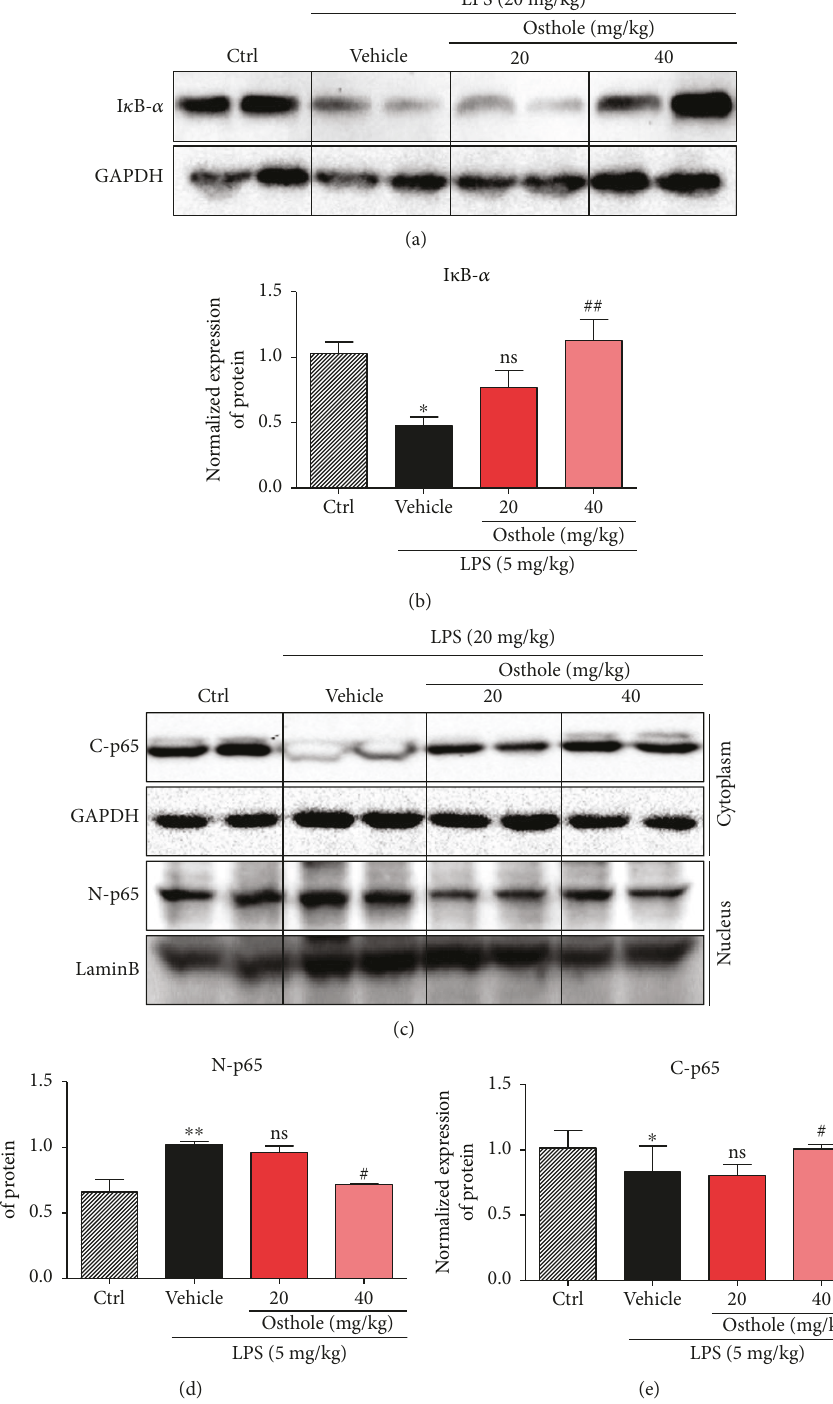
Figure 6: Osthole suppresses NF- κ B signaling in vivo . ALI was induced as described (Materials and Methods). Brie fl y, C57BL/6 mice were pretreated for 30 min with 20mg/kg or 40mg/kg osthole via ip injection, followed by intratracheal injection of 5mg/kg LPS, and lungs were sampled 6h later for Western blot analyses. (a) Representative Western blot detecting for I κ B- α ; GAPDH as loading control. (b) Densitometric quanti fi cation of blot in (a); values are reported as mean ± SEM relative to control (Ctrl); n = 4 . The bands were quanti fi ed by ImageJ and normalized to loading controls. (c) Representative Western blot analysis of the p65 subunit of NF- κ B from cytoplasmic and nuclear cell fractions (C-p65 and N-p65, resp.); GAPDH and lamin B as respective loading controls. Densitometric quanti fi cation of (d) N-p65 and (e) C-p65 from (c); values are reported as mean ± SEM ; n = 4 . The bands were quanti fi ed by ImageJ and normalized to loading controls. ns = not signi fi cant; ∗ p < 0 05 , ∗∗∗ p < 0 001 versus control (Ctrl). # p < 0 05 , ## p < 0 01 versus